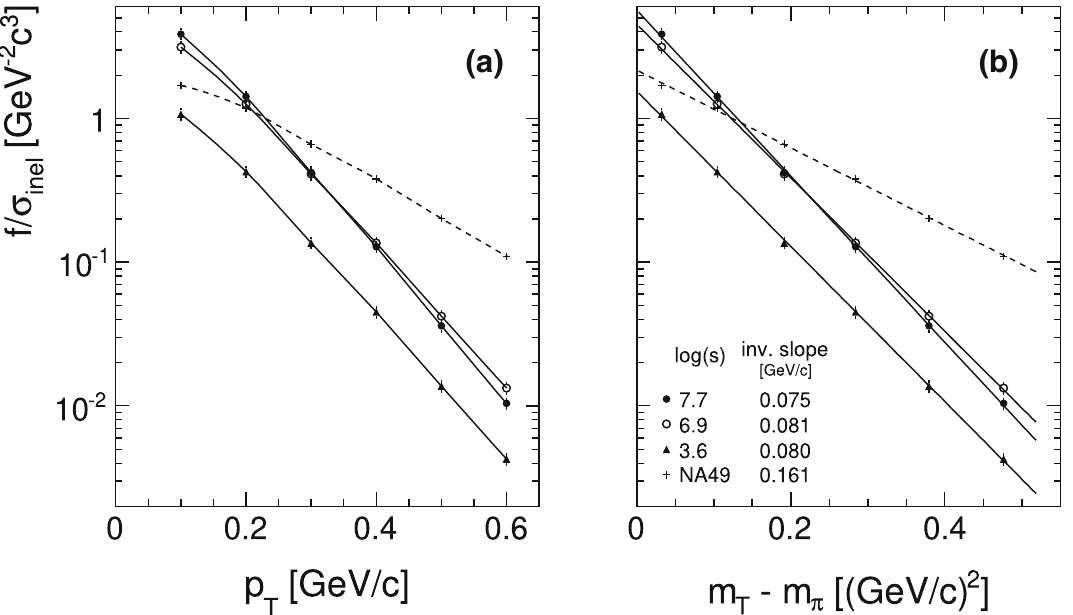
Fig. 127 a f /σ inel ( y = 0 , s , p T ) asa functionof p T fordifferent values oflog ( s ) compared tothe invariant cross sectionofNA49; b corresponding distribution as a function of m T −